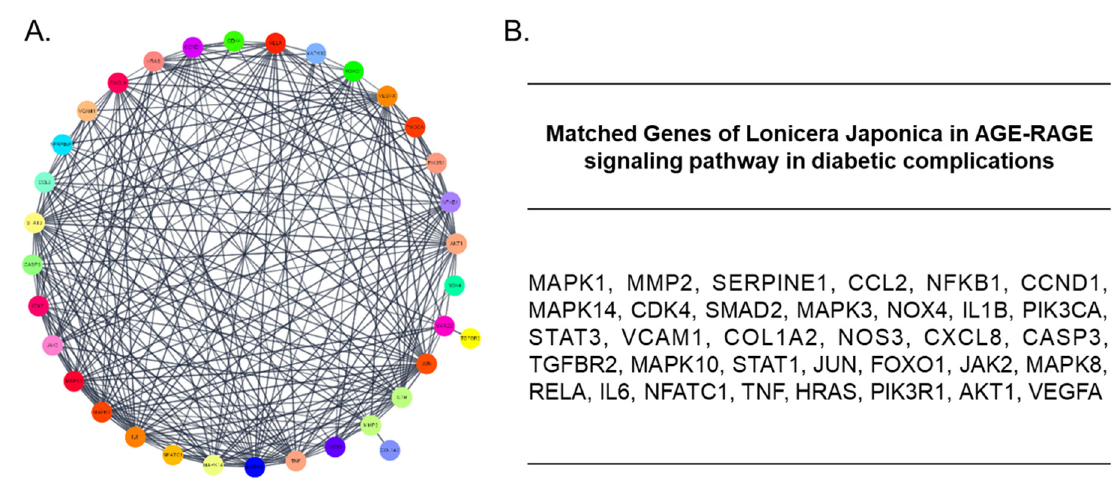
Figure 3. ( A ) The LJ network consisting of 34 nodes and 543 edges. ( B ) LJ genes matched with genes in the AGE-RAGE signaling pathway in the diabetic complications network (34 matched genes in